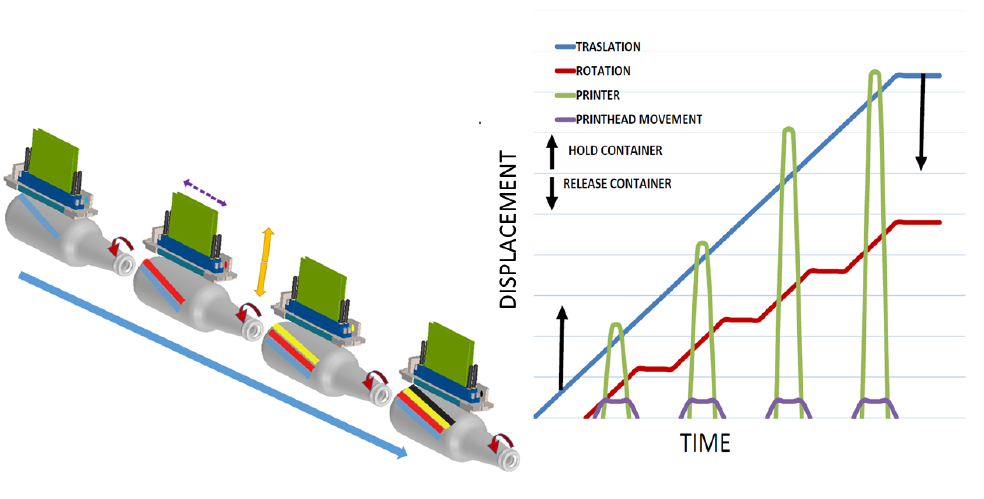
Figure 5. Topology phase diagram topology